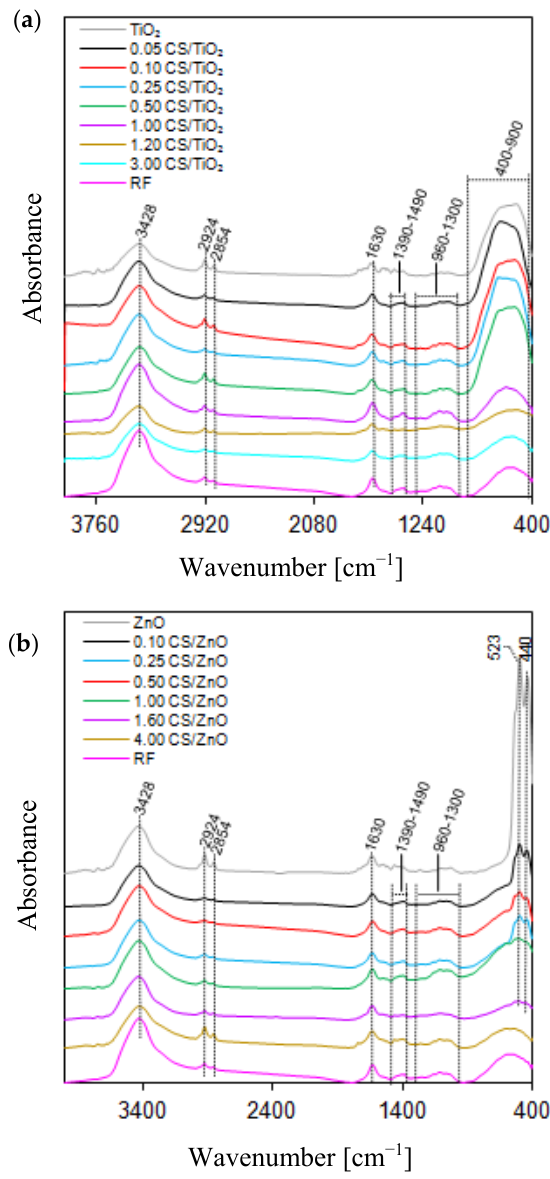
Figure 1. FT-IR spectrum of ( a ) CS/TiO 2 and ( b ) CS/ZnO samples. The TG/DTG curves of the thermal oxidative stability of all the TiO 2 - or ZnO-modified samples with different carbon sphere contents are shown in Figure 2a,b and Figure 3a,b, respectively. In the case of reference TiO 2 and ZnO semiconductors, only 2.30 and 1.25% weight losses were observed in a temperature range of 40–290 ◦ C. That weight loss was attributed to the desorption of the physically adsorbed water [47]. For the unmodified carbon sphere sample (assigned as CS), the total weight loss of about 99.6% was observed between 369 and 730 ◦ C, corresponding to the differential thermogravimetric (DTG) profile with a maximum at 674 ◦ C, which could be assigned to breaking C–O bonds and desorption of residual organic compounds [48]. The results also show that both groups of